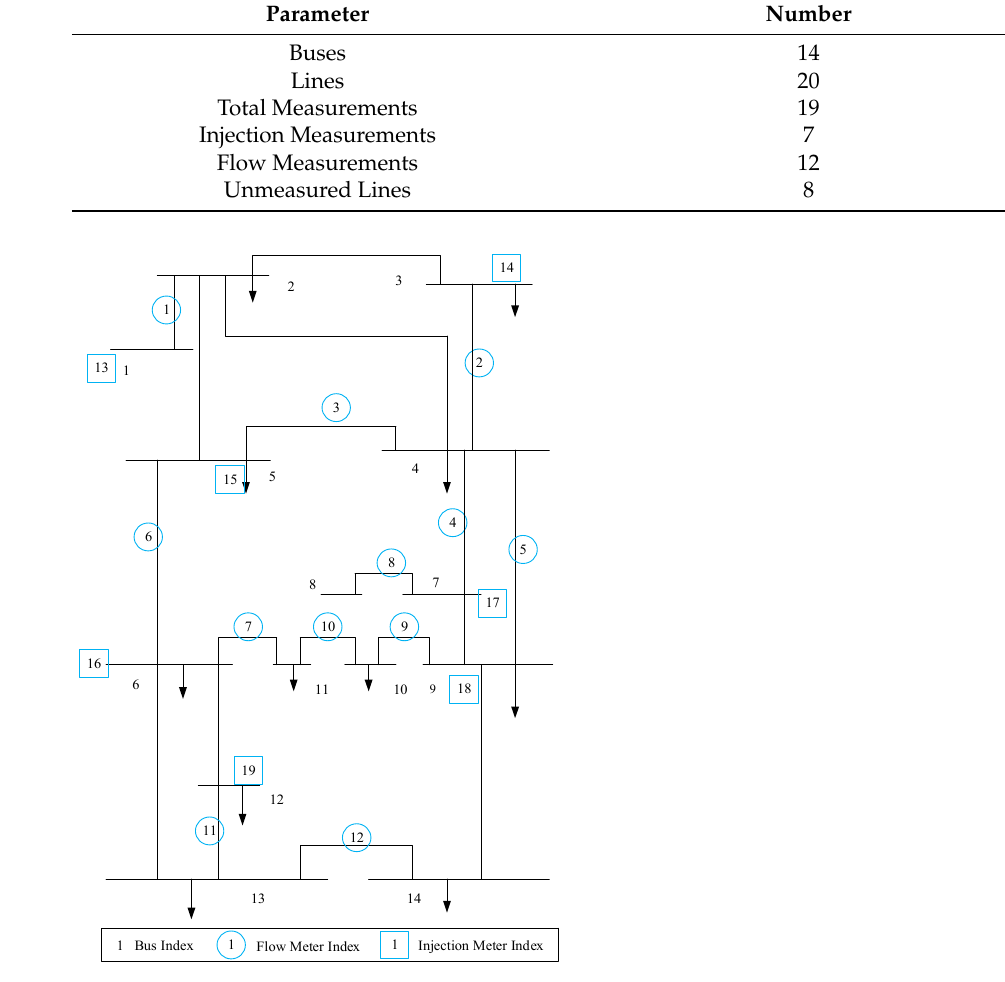
Figure 3. IEEE14-bus Test System.